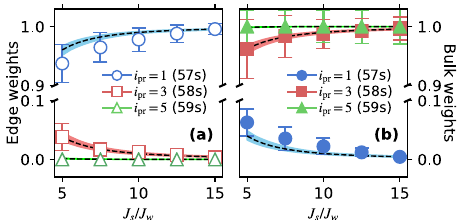
Fig. 3 Synthetic-lattice-eigenstate decomposition obtained from spectral- line areas [e.g. Fig. 2a, c] for the con fi guration with TPS [Fig. 1b]. Error bars re fl ect fi t uncertainties. ( a ) Fraction of the entire signal under the spectral features corresponding to the edge states for probe tuned near site i pr (Rydberg level) indicated in the legend. The line is the sum of the squares of the calculated overlaps of the SSH edge eigenstates with the i pr site found from a direct diagonalization of Eq. (1) with δ i = 0 [e.g. Fig. 2b]. ( b ) Fraction of the entire signal under the bulk state features and calculated sum of squares of the overlaps of the SSH bulk eigenstates with the i pr site.